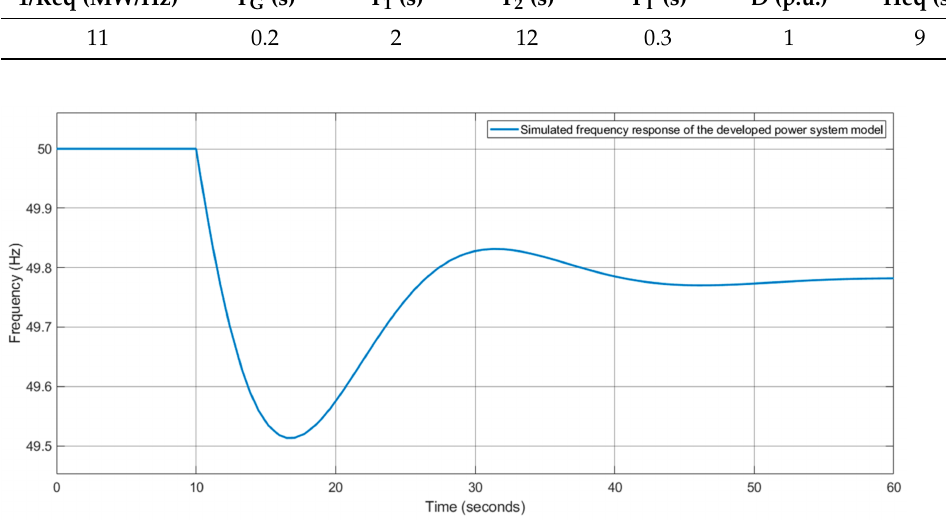
Figure 8. Simulated frequency response of the developed power system model incorporated a loss of 1.22 GW of power generation at a 25 GW base load.